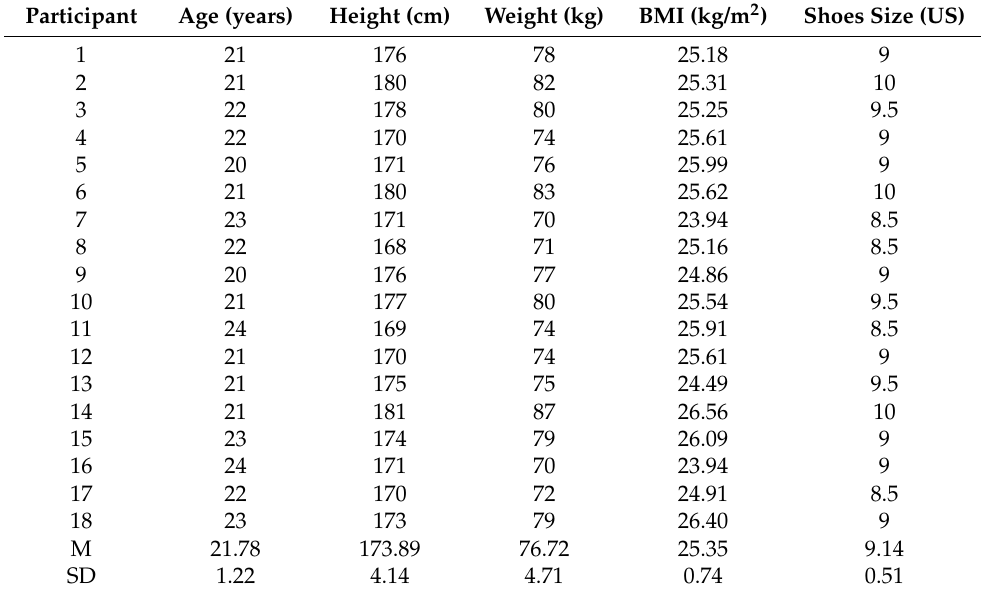
Table 1. Anthropometric characteristics of participants.